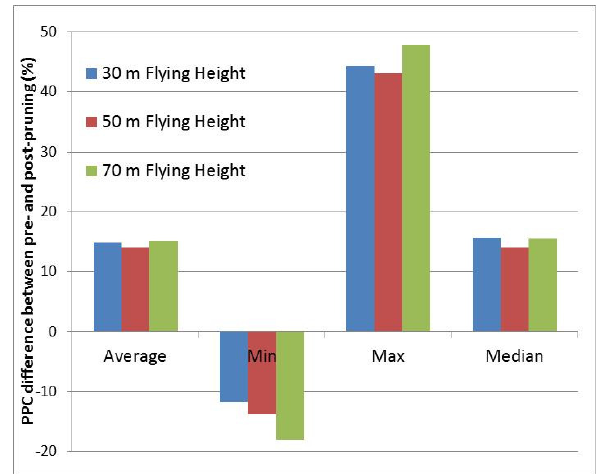
Figure 9. Pre- and post-pruning differences for the 89 field assessed lychee trees in PPC as a function of flying